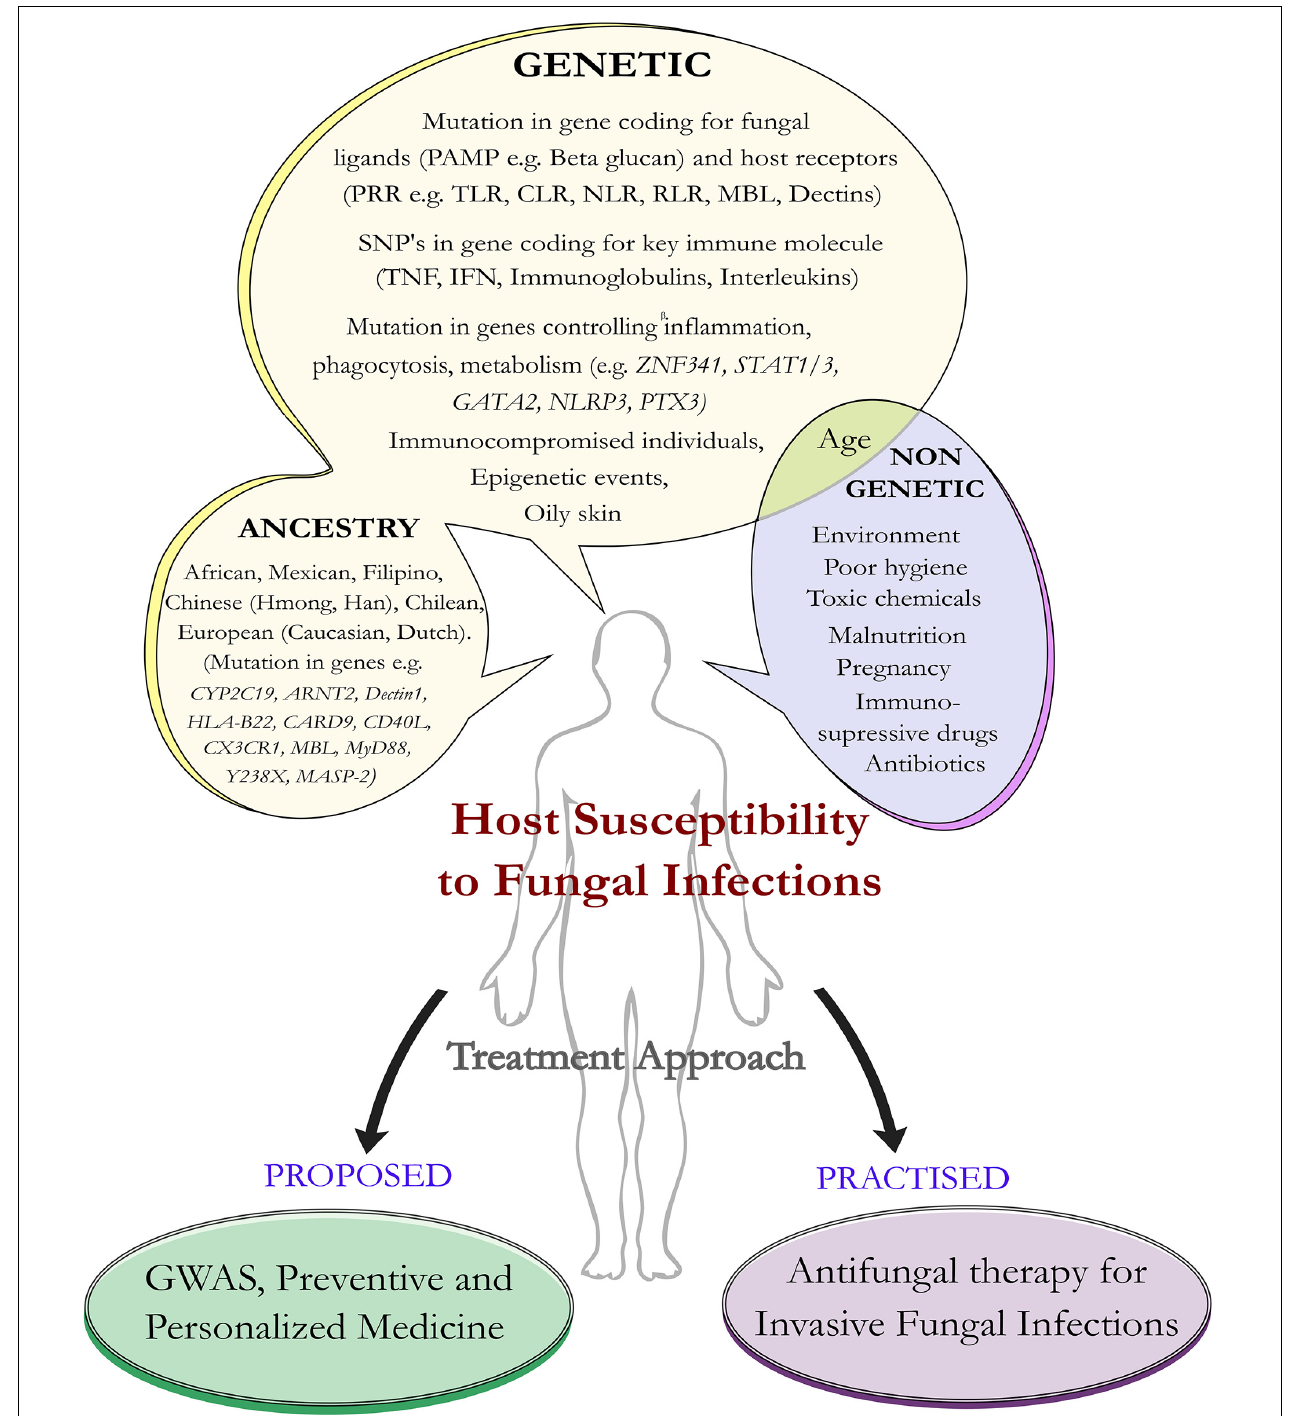
FIGURE 1 | Host susceptibility to invasive fungal infection: predisposing factors and treatment approach. Schematic diagram represents predisposition of the host to certain factors that make them susceptible to fungal infections. Such factors can be genetic as well as non-genetic. Apart from genetic mutations in the host ligand, fungal receptors, and immune genes, human ancestry plays an important role in susceptibility toward invasive fungal infections. The future approaches would be geared toward the investigation (as part of preventive medicine) of the genetic mutations that predispose individuals to fungal infections and offer personalized medicine compared to the more traditional approach that is practiced in the form of antifungal